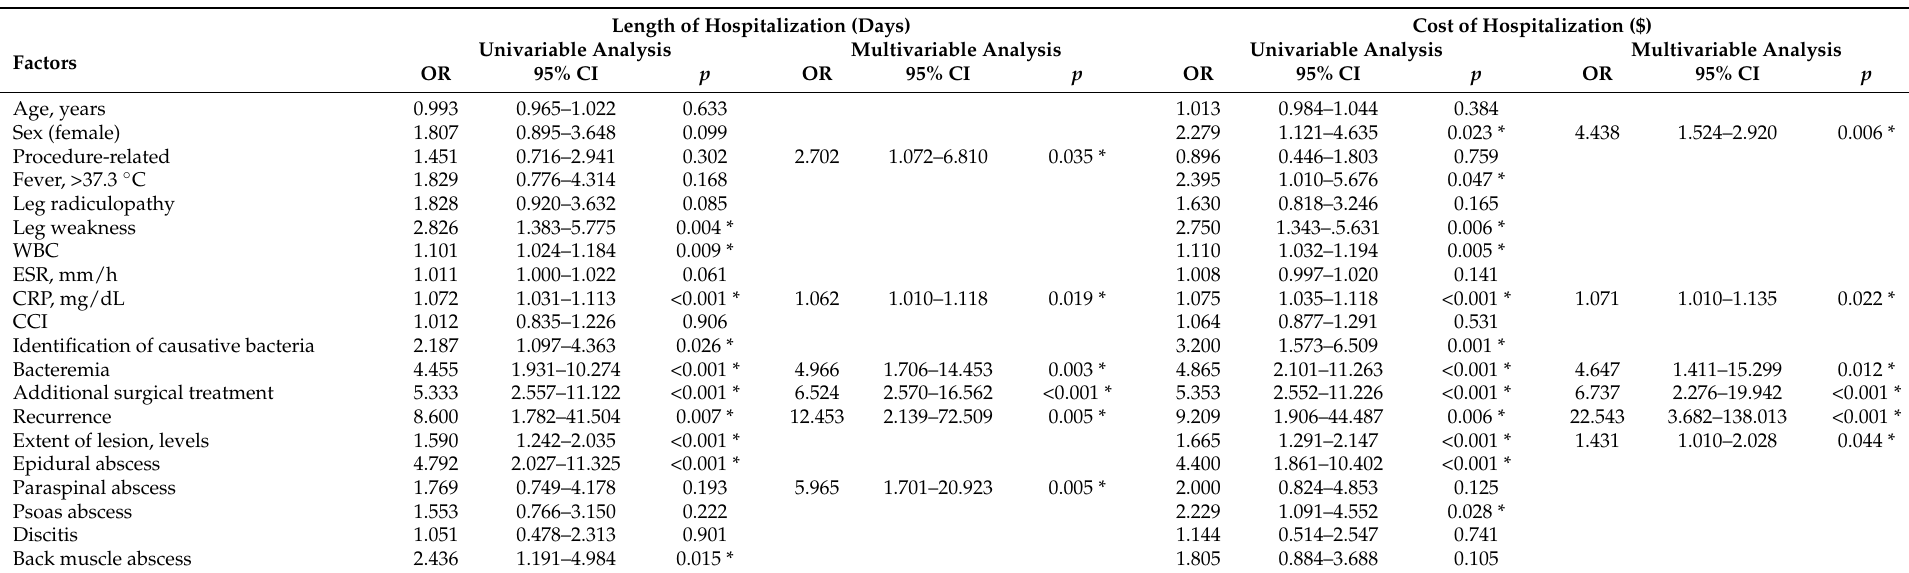
Table 5. Logistic regression analysis of clinical factors associated with above-average medical burden. WBC, white blood cell; ESR, erythrocyte sedimentation ratio (normal range < 20 mm/h); CRP, C-reactive protein (normal range < 0.5 mg/dL); CCI, Charlson comorbidity index; *, p <